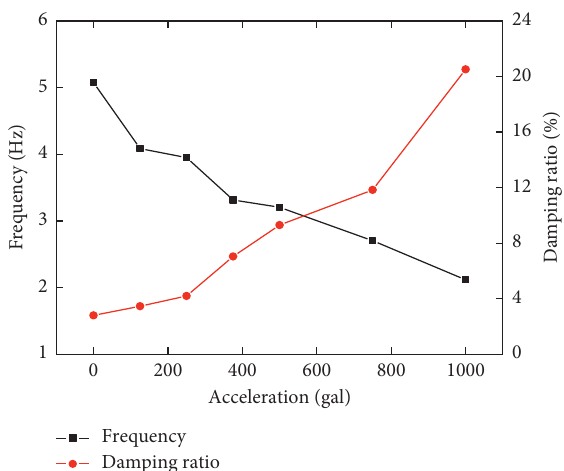
Figure 4: The change of fundamental frequency and damping